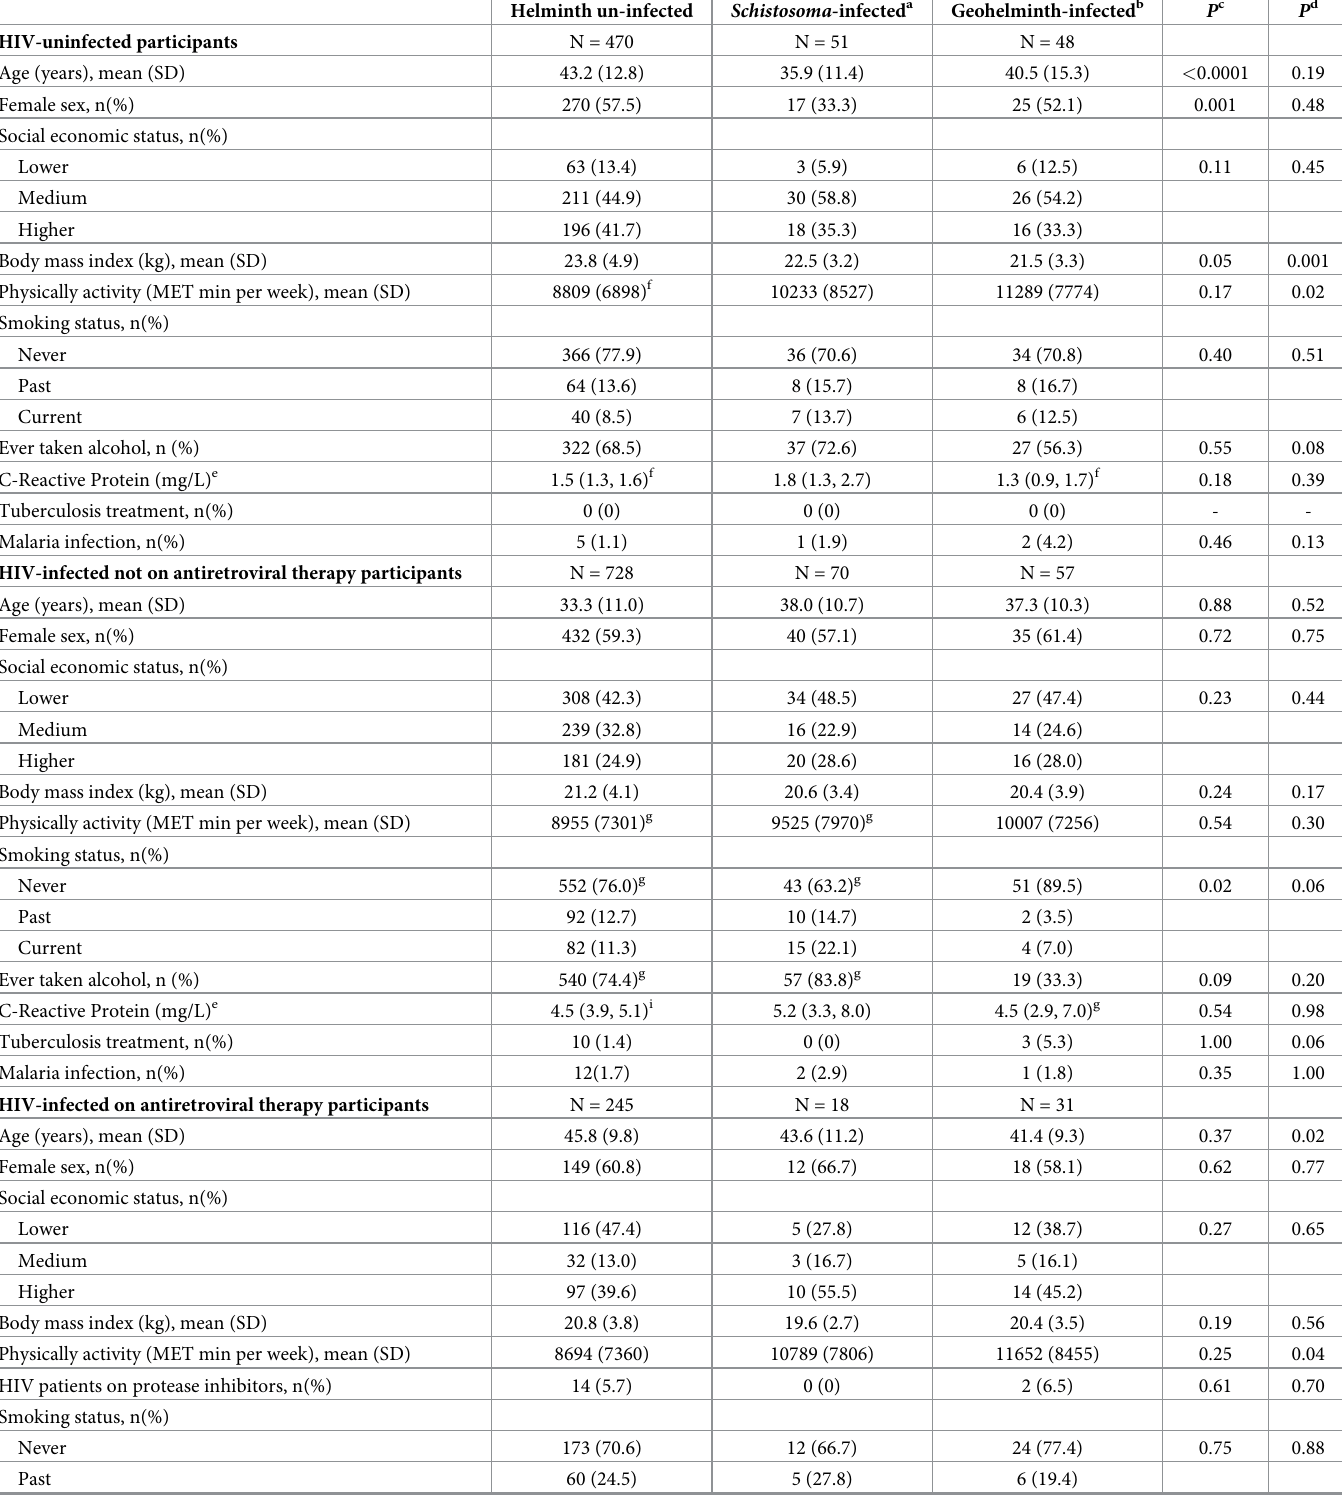
Table 1. Background characteristics by helminth infection